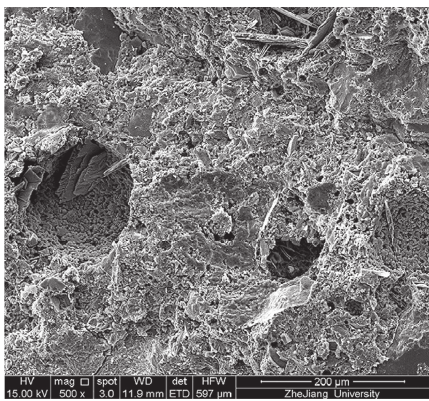
Figure 5: Microstructure of CAM without nanoparticles.